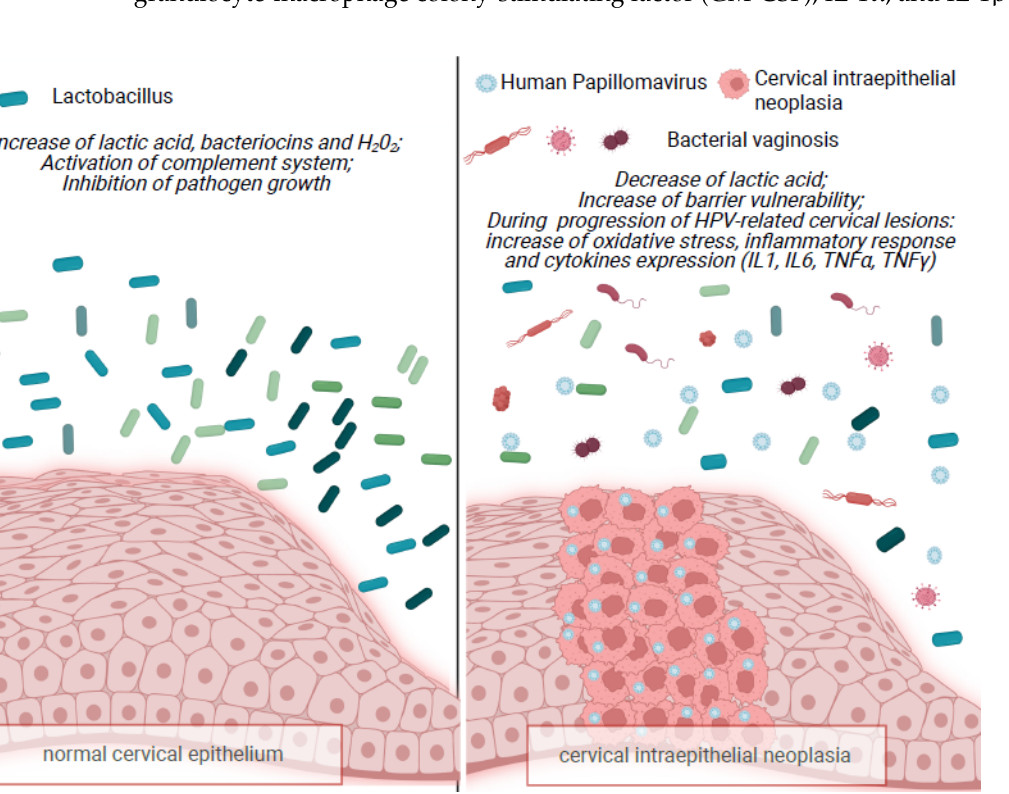
Figure 1. Summary of the interplay of factors influencing vaginal microbiota. Created with Bio- render.com.